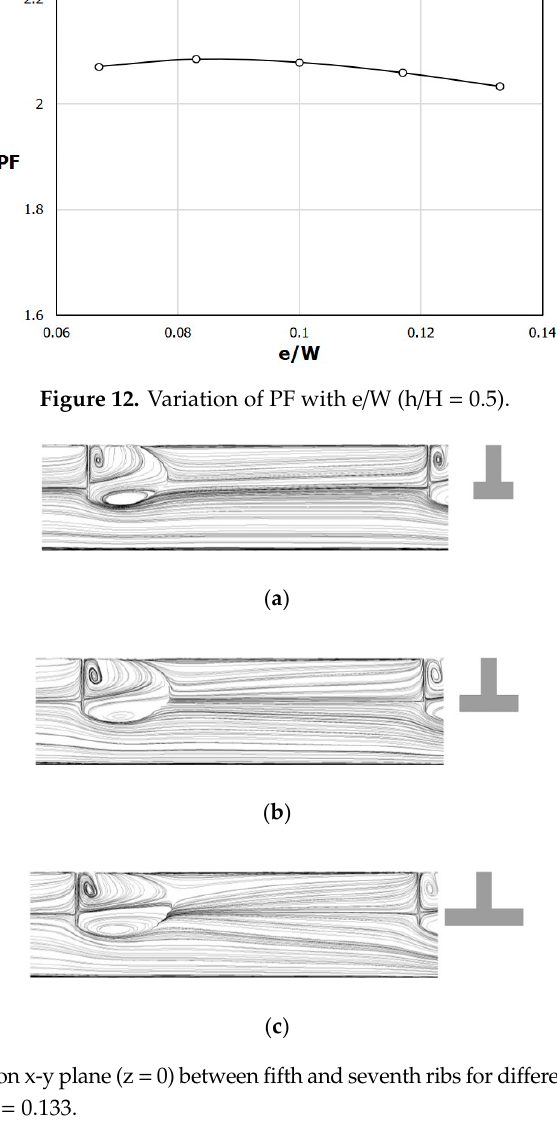
Figure 14. Nusselt distributions on the heated surface between fifth and seventh ribs for different e/W. ( a ) e/W = 0.067; ( b ) e/W = 0.10; ( c ) e/W = 0.133.